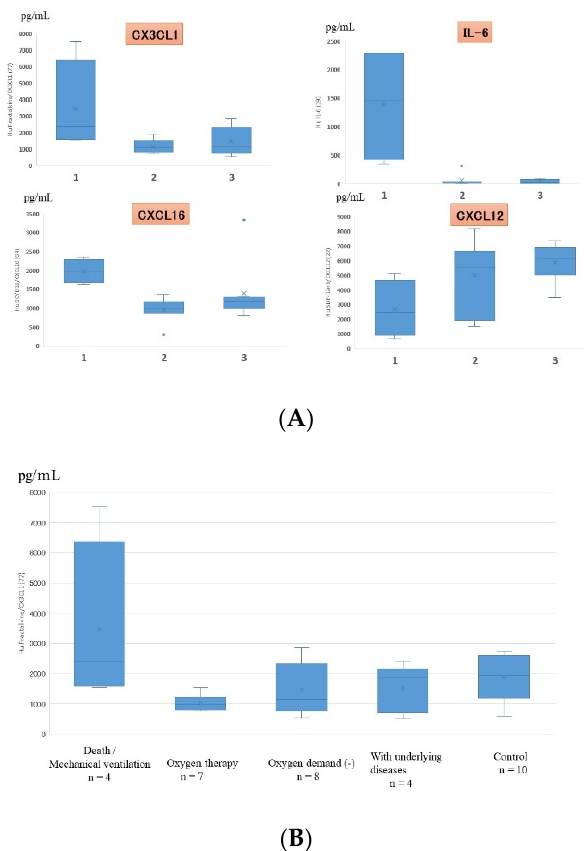
Figure 4. ( A ) Cytokines that showed statistically significant differences in serum expression levels in children with different severities of RSV infection (only 4 out of the 48 cytokines showed statistically significant differences). 1: death/mechanical ventilation; 2: oxygen therapy; 3: oxygen demand ( - ). ( B ) Serum fractalkine/CX3CL1 levels in patients with different severities of RSV infection. Box and whisker plot (box: interquartile range; whiskers: minimum and maximum).